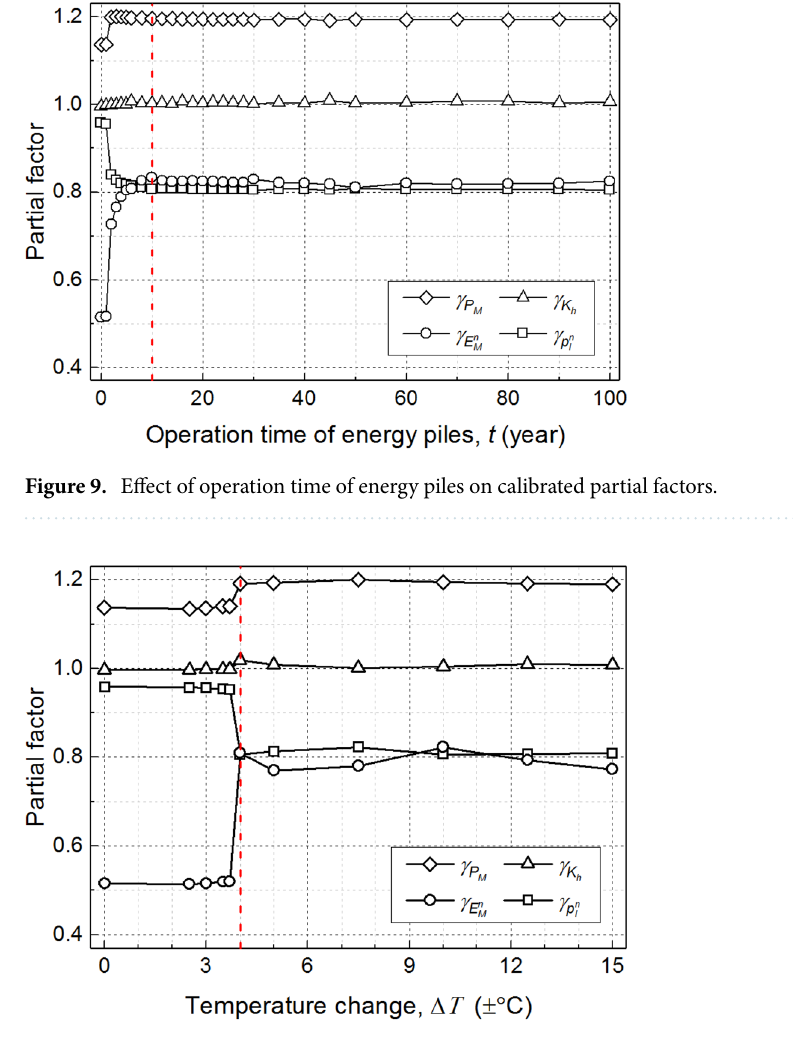
Figure 10. Effect of temperature change on calibrated partial factors.